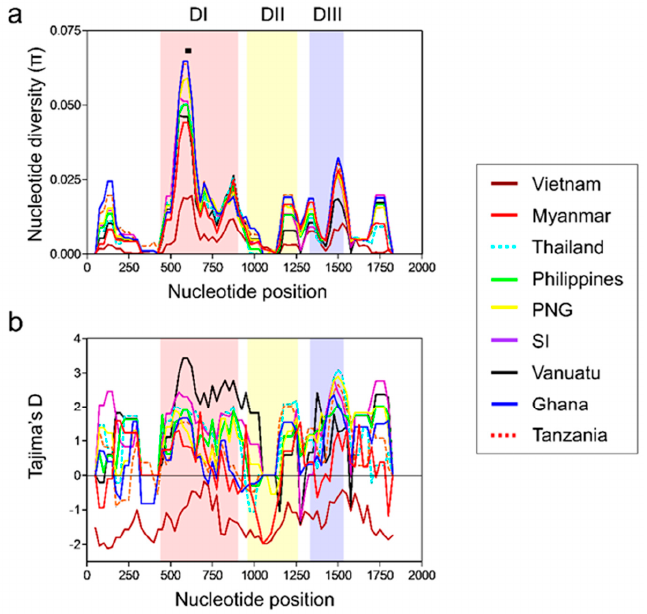
Figure 5. Nucleotide diversity and natural selection of global pfama-1 . ( a ) Nucleotide diversity. Sliding window plot showed nucleotide diversity ( π ) values across global pfama-1 sequences. A window size of 100 bp and a step size of 25 bp were applied. The cluster 1 of loop I (C1-L) region, which is located on the π peak of domain I, is marked with a black line. ( b ) Natural selection. Sliding window of Tajima’s D was analyzed for global pfama-1 . A window size of 100 and a step size of 25 were applied. The patterns of π and Tajima’s D of pfama-1 from each county are represented with different colors. DI, domain I; DII, domain II; DIII, domain III. PNG, Papua New Guinea; SI, Solomon Islands. The global patterns except Vietnamese pfama-1 have been analyzed previously [25], and the previous data were applied to analyze overall patterns.